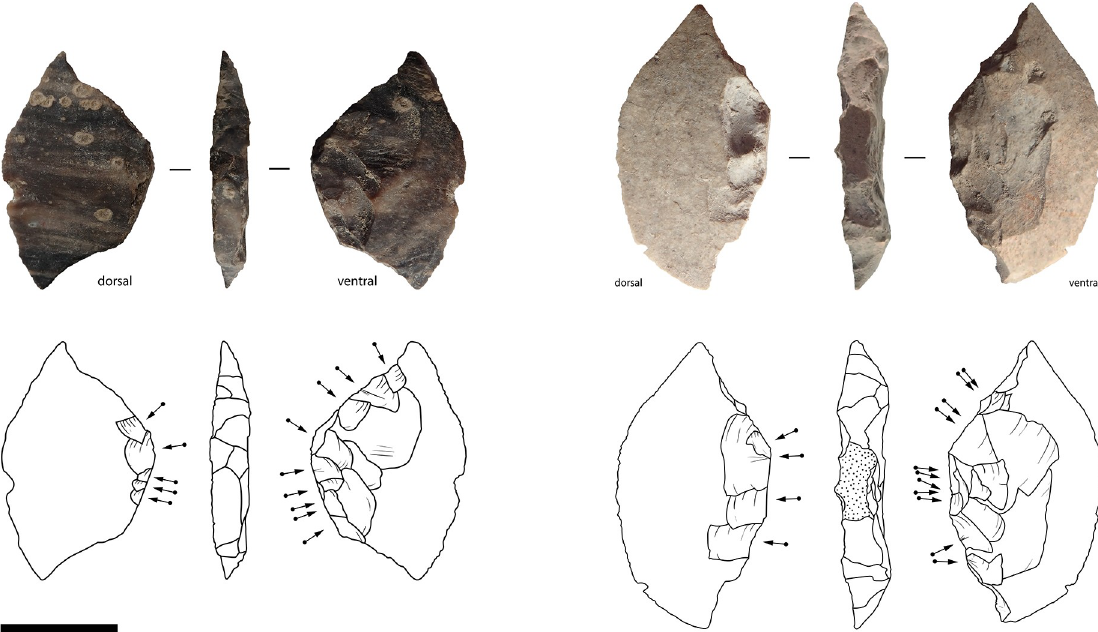
Fig 8. Retouched backed microliths. Backed microliths from Leang Panninge with extensive retouch across the dorsal and ventral faces. Retouching was done after the artefacts were backed, using the backed edge as the striking platform. Scale bar = 1 cm.